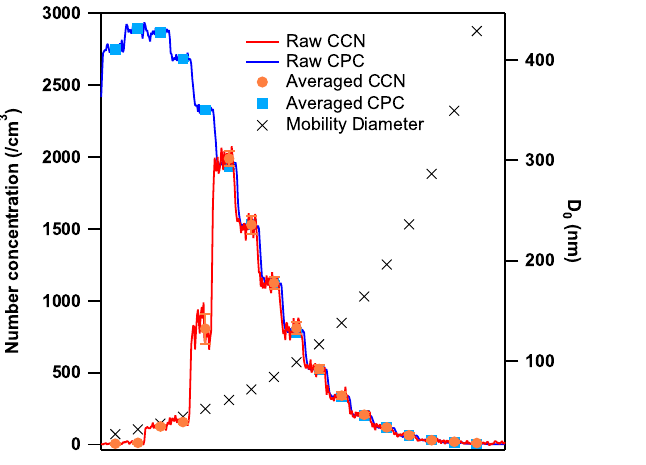
Fig. 6. Example DMPS-CCN distribution of nebulised sodium chloride aerosol at 0.26% supersaturation. The blue squares show the averaged N CN , the orange squares show the averaged N CCN . The crosses indicate the mobility diameter. The dashed lines show the raw data.